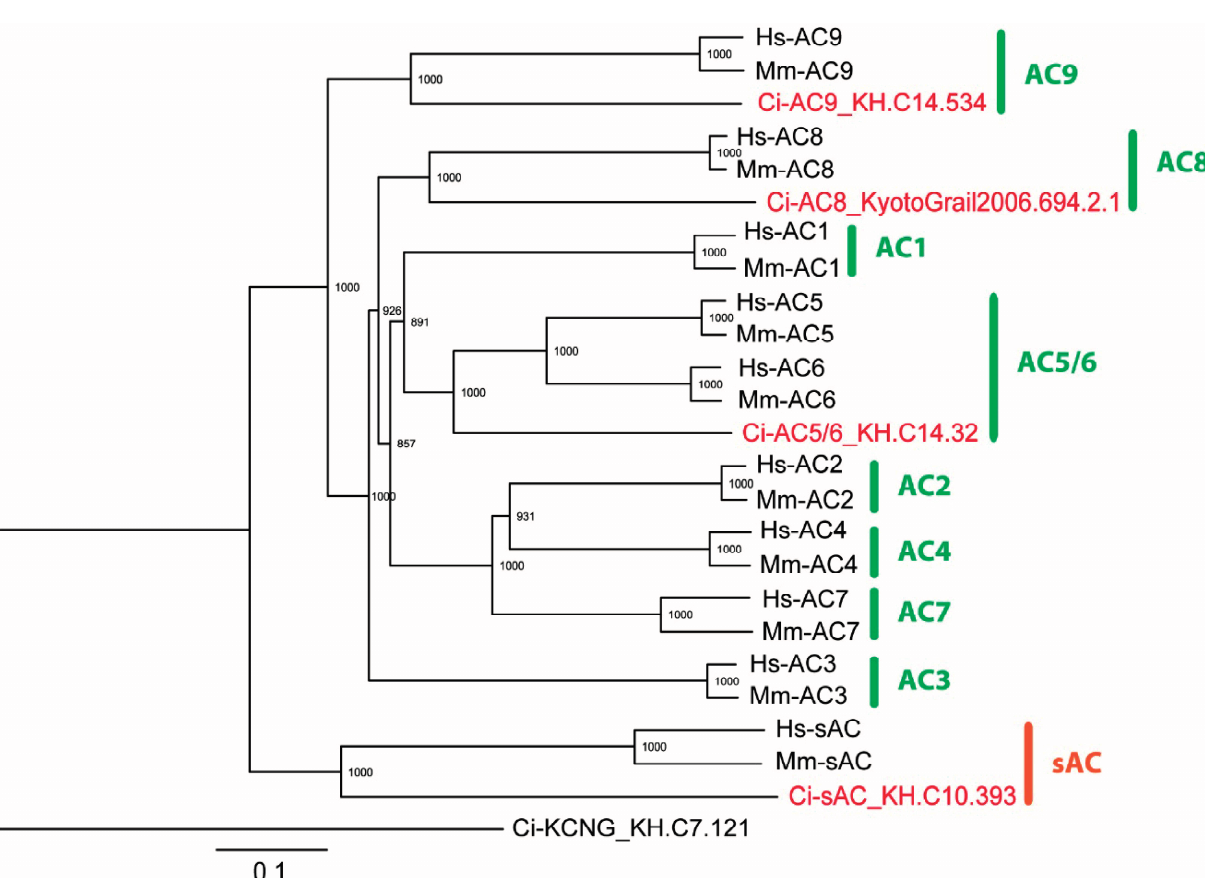
Figure 1. Phylogenetic analysis of adenylyl cyclases. Ciona tetrameric potassium-selective cyclic nucleotide-gated channel (Ci-KCNG) was used as the outgroup. The value on each branch represents the number of times that a node was supported in 1000 bootstrap pseudo replications. BLASTP search of adenylyl cyclase (AC) against Ciona genome revealed four AC gene models. Phylogenetic analysis suggests that ACs encoded by these four genes are grouped with mammalian AC5/6, AC8, AC9 and soluble AC (sAC) respectively. Accession numbers of proteins are: Homo sapiens : Hs-AC1 (NP_066939), Hs-AC2 (NP_065433), Hs-AC3 (NP_004027), Hs-AC4 (NP_640340), Hs-AC5 (NP_899200), Hs-AC6 (NP_056085), Hs-AC7 (NP_001105), Hs-AC8 (NP_001106), Hs-AC9 (NP_001107), Hs-sAC (NP_060887); Mus musculus : Mm-AC1 (NP_033752), Mm-AC2 (NP_705762), Mm-AC3 (NP_001153008), Mm-AC4 (NP_536683), Mm-AC5 (NP_001012783), Mm-AC6 (EDL04180), Mm-AC7 (NP_001032813), Mm-AC8 (NP_033753), Mm-AC9 (NP_033754), Mm-sAC (NP_766617). Sequences of Ciona proteins are obtained from the Ghost database (http://ghost.zool.kyoto-u.ac.jp). Proteins encoded by Ciona gene models are indicated in red. The bars in green or in red represents tmAC or sAC,